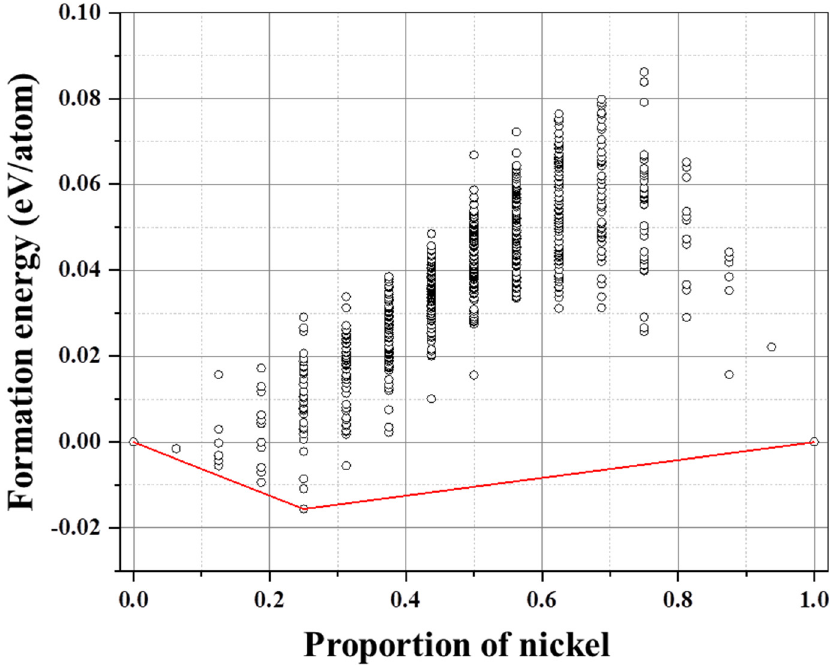
Figure 3. Formation energy of Zr 2 (Fe 1 − x Ni x ) on first-principles calculation plus CE. The red solid line connects the formation energies of x = 0 at% and 100 at% with the minimum value of x = 24 at%.